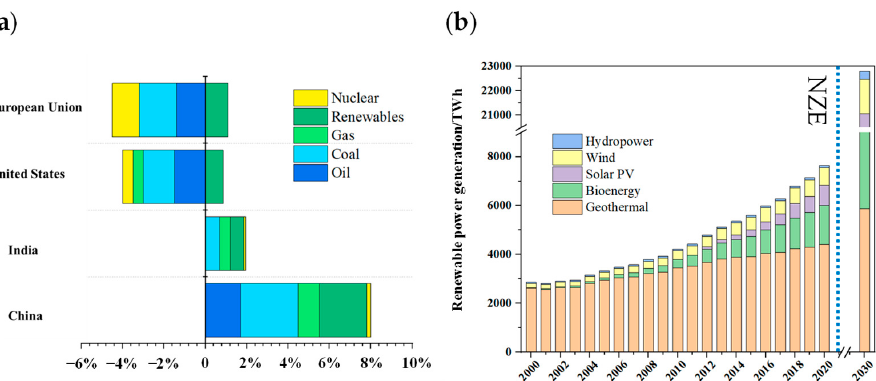
Figure 1. Global energy demand by region and fuel: ( a ) change in fuel in 2021 relative to 2019 [2]; ( b ) trends of renewable installation capacity [3].